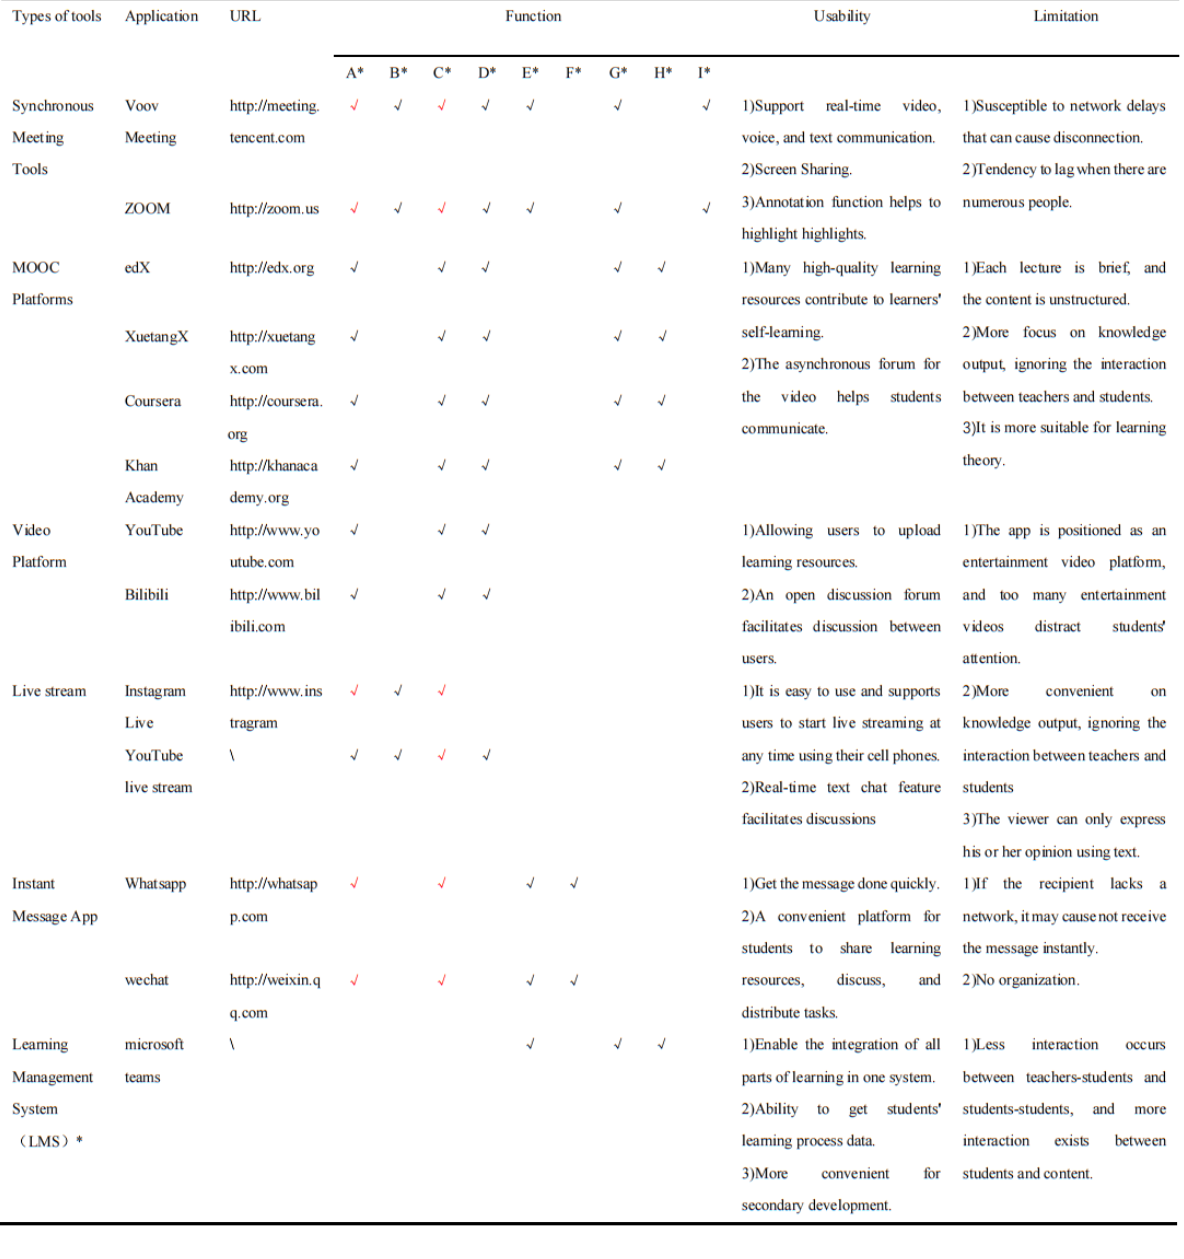
Figure 4. Compare different virtual-tool characters, functions, advantages and limitation; A*: Video and voice presentation: one way interaction in black and bidirectional interaction in red; B*: Real-time interaction; C*: Text-only communication: synchronous interaction in black and asynchronous in reds interaction in red; D*: Screen Sharing; E*: Collaborative Learning; F* :Notice; G*: Test; H*: Learning Process Record; I*: Built-in Recording; Since the specific functions of LMSs are different, we will just discuss their general functions.; LMS*: learning management system is an application that support most learning activities in a